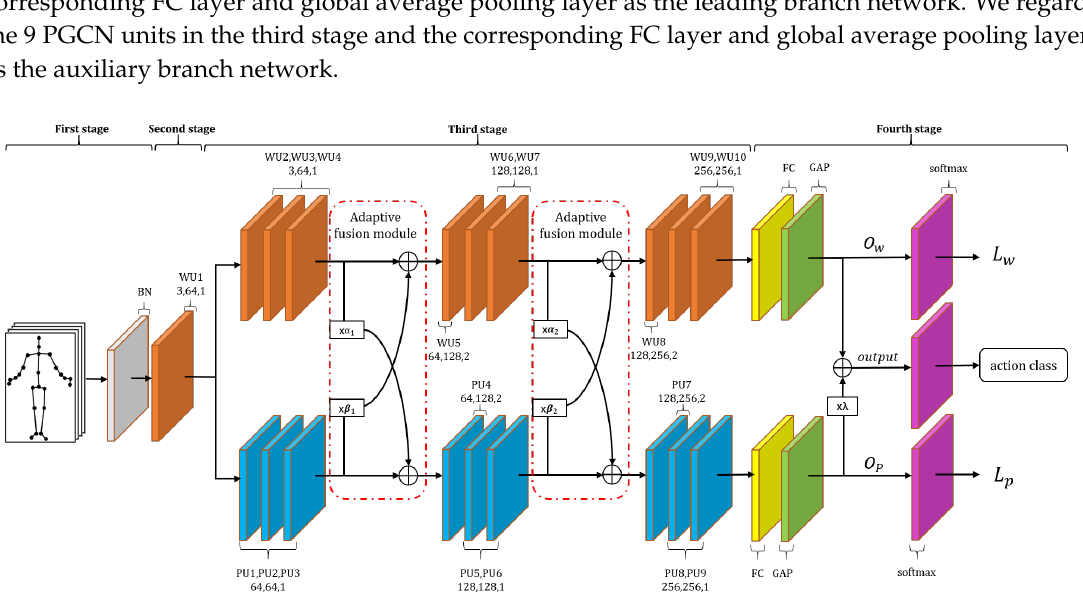
Figure 7. The overall architecture of the whole and part adaptive fusion graph convolutional neural network (WPGCN). There is a total of 10 WGCN units (WU1-WU10) and nine PGCN units (PU1-PU9). The three numbers of each unit represent the number of input channels, the number of output channels, and the stride, respectively. α 1 , α 2 , β 1 , β 2 , and λ denotes the fusion parameters. (cid:76) denotes the element-wise